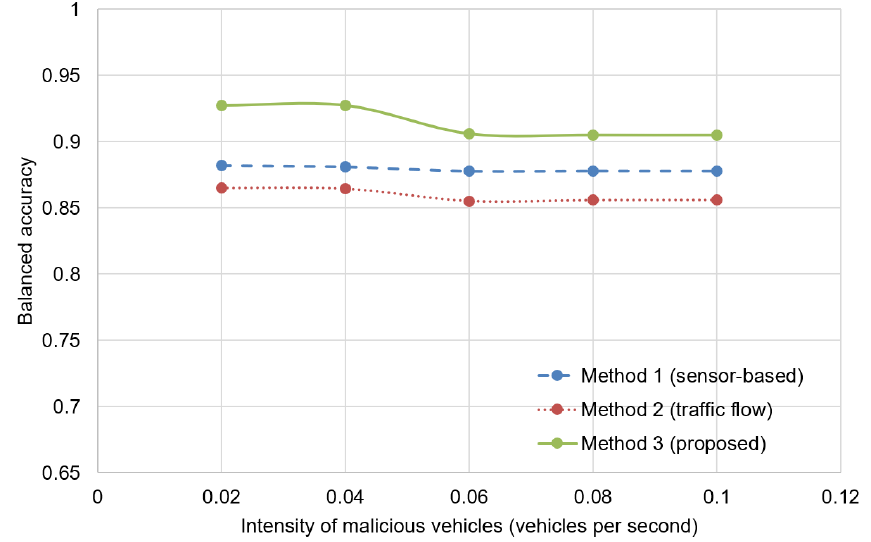
Figure 10. Accuracy of malicious data detection for different intensities of malicious